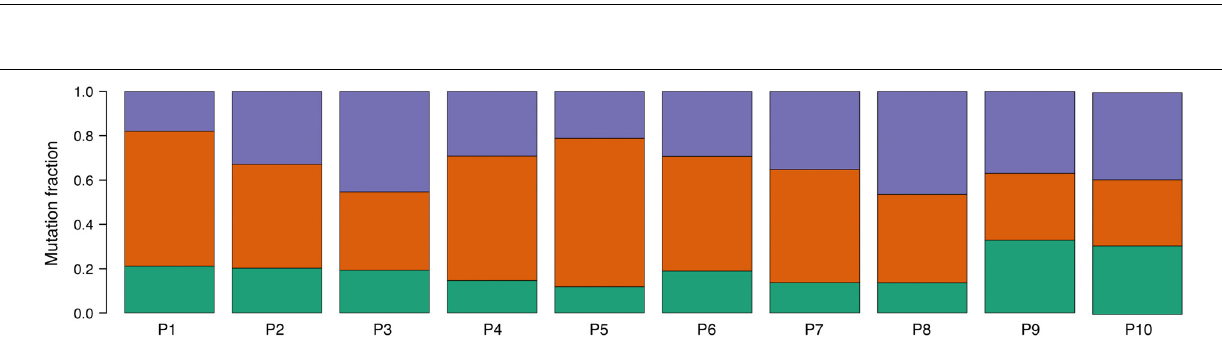
Frontiers in Genetics |